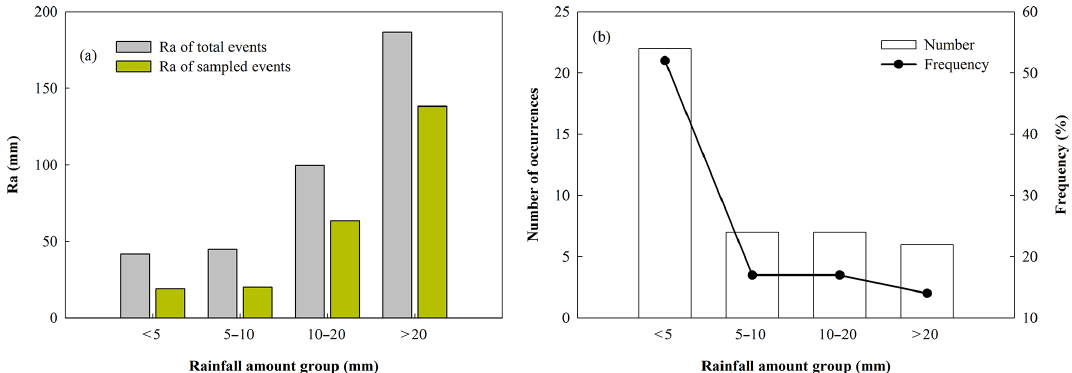
Figure 3. Statistical characteristics of rainfall events from June to September 2016: (a) characteristics of total and sampled rainfall amount, (b) characteristics of rainfall amount grades and its occurrence frequency.